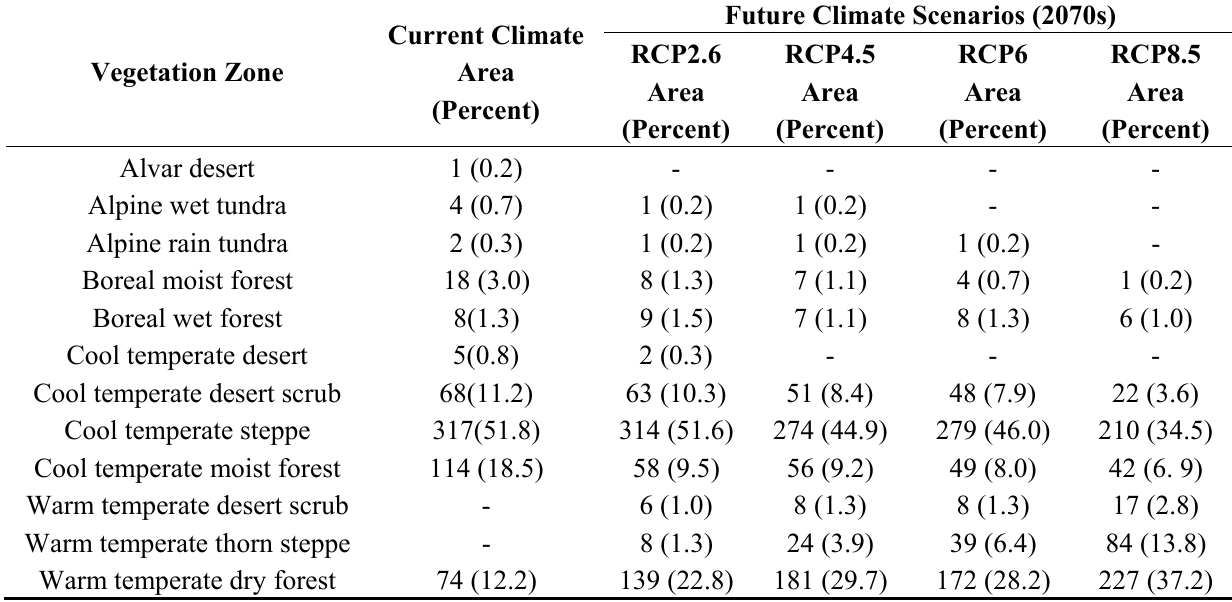
Table 2. The area proportion (%) of vegetation zones under the current climate (1950–2000) and future climate change scenarios (2070s). Area proportion was calculated from each corresponding map from grid cells with 4000 m × 4000 m